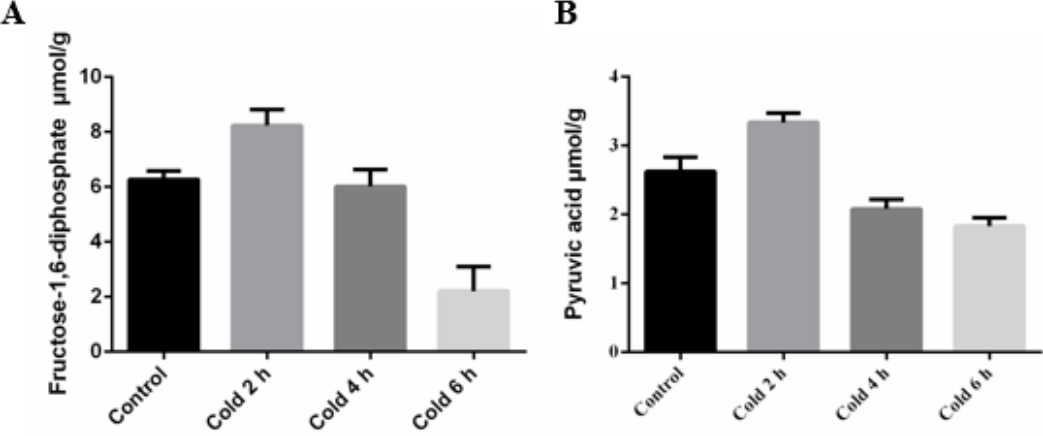
Figure 2. Effect of acute cold stress on the levels of glycolytic intermediates ( A ) fructose-1,6-diphosphate (FDP) and ( B ) pyruvic acid (PA) in the liver. The data are presented as mean ± SEM ( n = 8). Statistically significant differences are indicated.